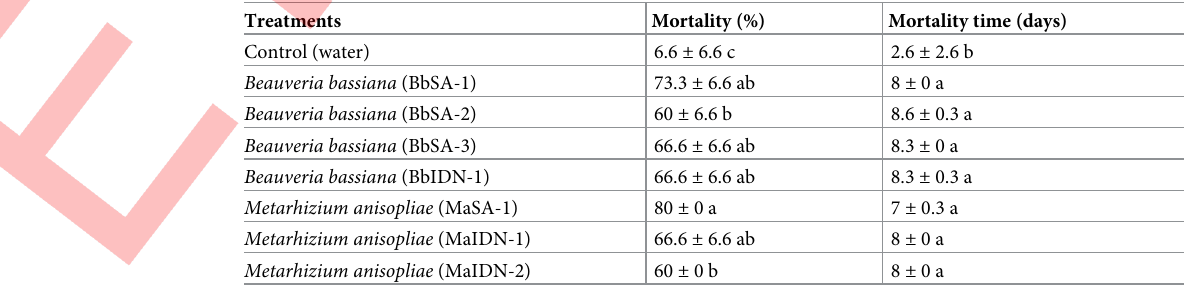
Table 4. Mean mortality (% ± SE) of pupae of red palm weevil treated with Metarhizium anisopliae and Beauveria bassiana under laboratory conditions at 25 ± 2˚C and 85 ± 5%